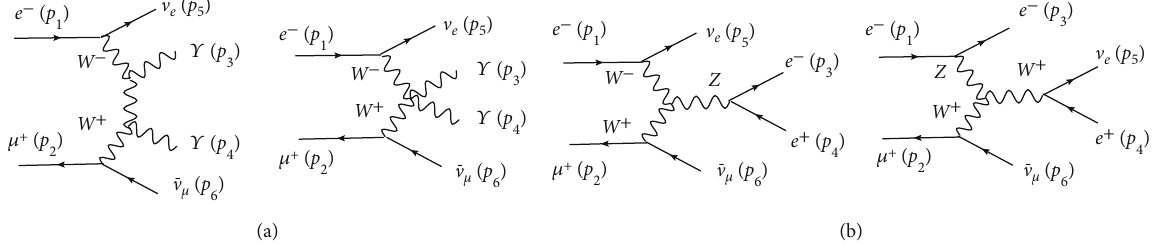
− μ + ⟶ e − e + ν (cid:1) ν (cid:1) ν μ and (b) e μ e e